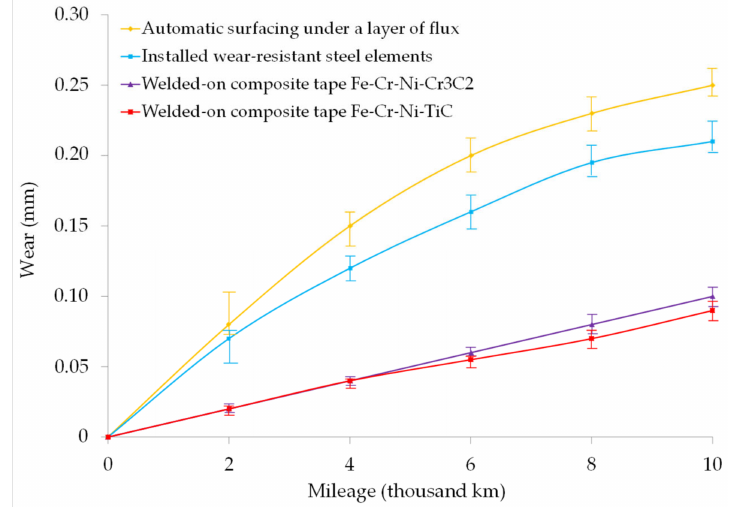
Figure 7. Experimental dependences of the wear of the CBRTB in function of the mileage of an empty freight car.